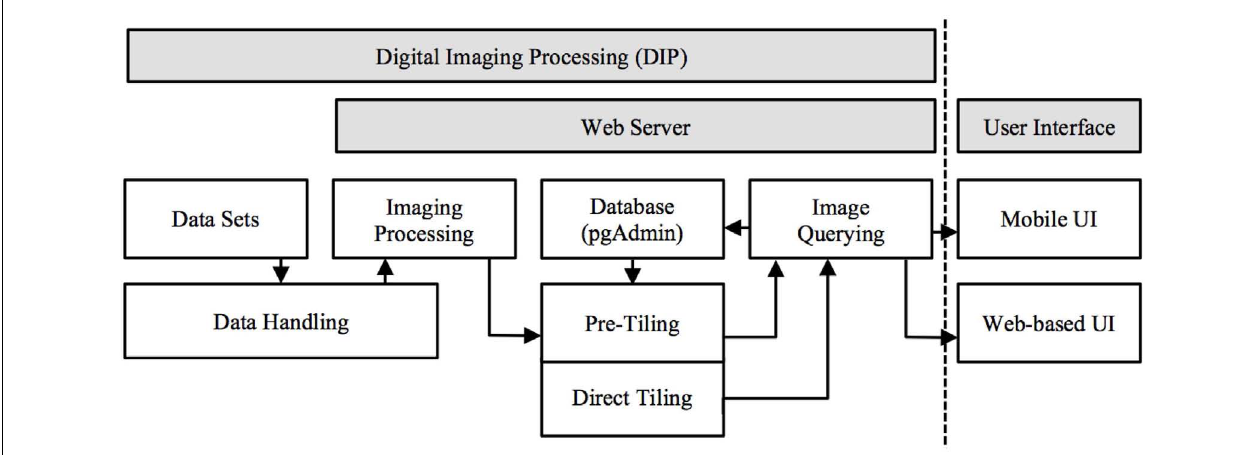
FIGURE 1 | Mobile digital imaging processing system architecture . Image processed in server side and presented in front-end UI (data float from left to right and handled based on dataset format).